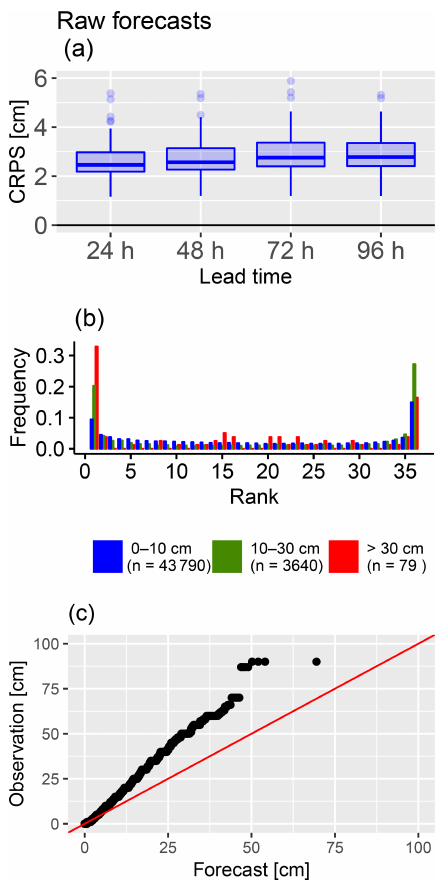
Figure 3. Evaluation of raw HN forecasts from PEARP-S2M during winter 2017–2018. (a) CRPS of HN as a function of prediction lead time. The boxplot represents the variability of scores between the 113 stations. (b) Rank histograms of HN forecasts for three classes of HN ensemble mean (indigo: [ 0cm , 10cm [ , cyan: [ 10cm , 30cm [ , red: [ 30cm , +∞[ ). (c) Quantile–quantile plot: the black dots repre- sent sorted observations as a function of the forecast quantiles for the equivalent frequency levels. Red line illustrates the ideal distri-